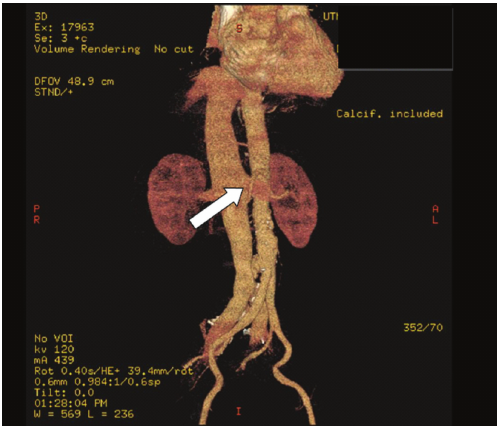
Figure 1: Arrow points to the fistulous connection between the aorta and the inferior vena cava.